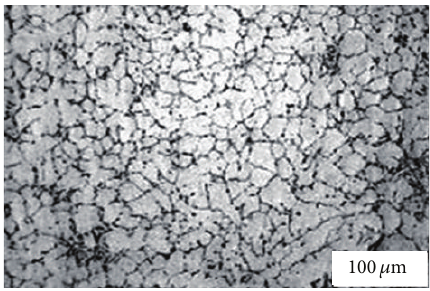
Figure 13: Microstructure of A356 alloy obtained by NRC method [41].